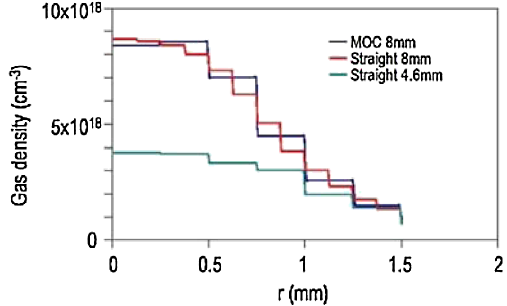
FIG. 9. Radial density lineouts at 3 mm downstream of the nozzle exit for each of the three nozzles at steady state.